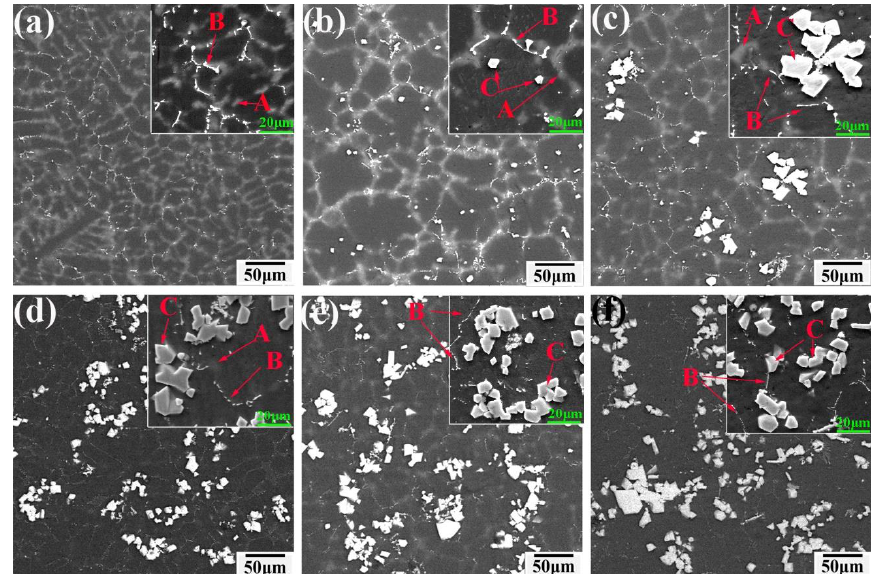
Figure 1. BSE-SEM images of the as-cast Mg-6Y alloys with the different addition Al contents: ( a ) 0.5%; ( b ) 1%; ( c ) 2%; ( d ) 3%; ( e ) 4%; ( f )